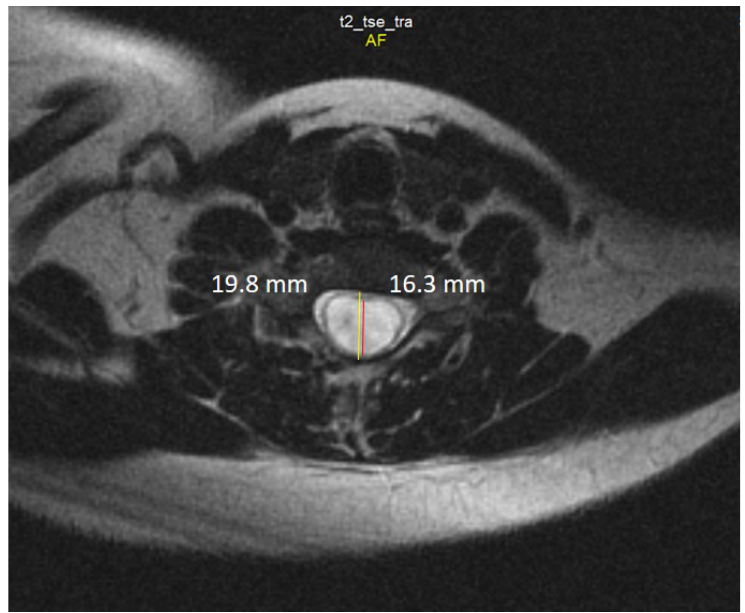
Figure 4. Sequential sagittal T2-weighted MRI scans of the thoracic spine demonstrate the syrinx (white arrow) extending inferiorly down to the Th12 level with the greatest dilation around Th3- Th7 (between the red lines).